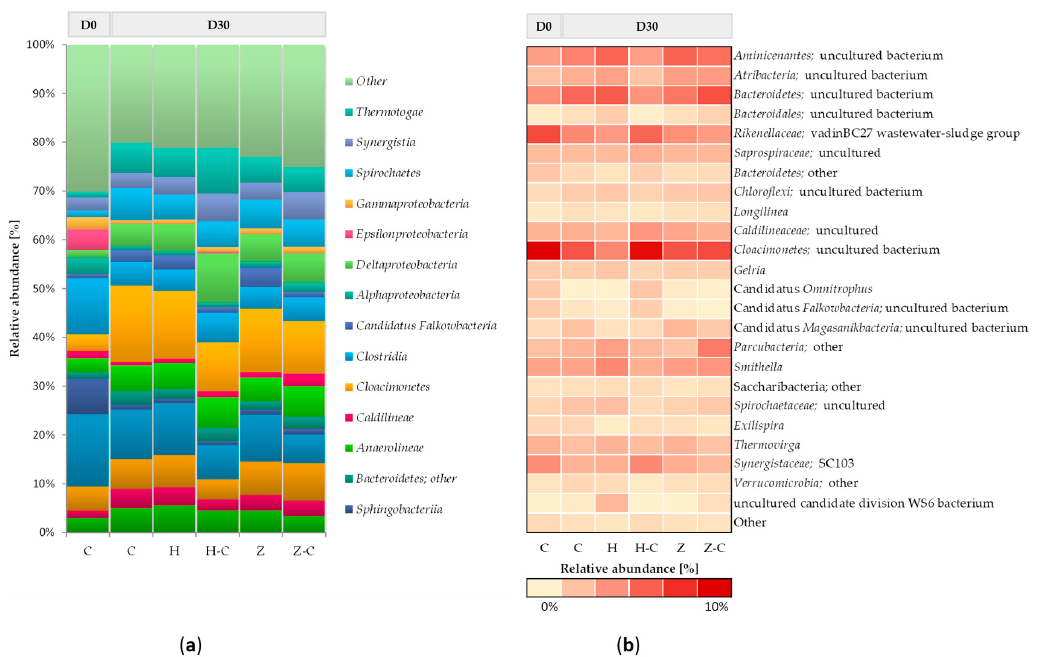
Figure 2. Relative abundance of bacterial OTUs: ( a ) bacterial classes with an abundance > 3% and ( b ) bacterial genera with an abundance > 1% in at least one variant are shown. C: control; H: halloysite; H-C: halloysite-colonisation; Z: zeolite; Z-C: zeolite-colonisation; D0: Day 0; D30: Day 30.